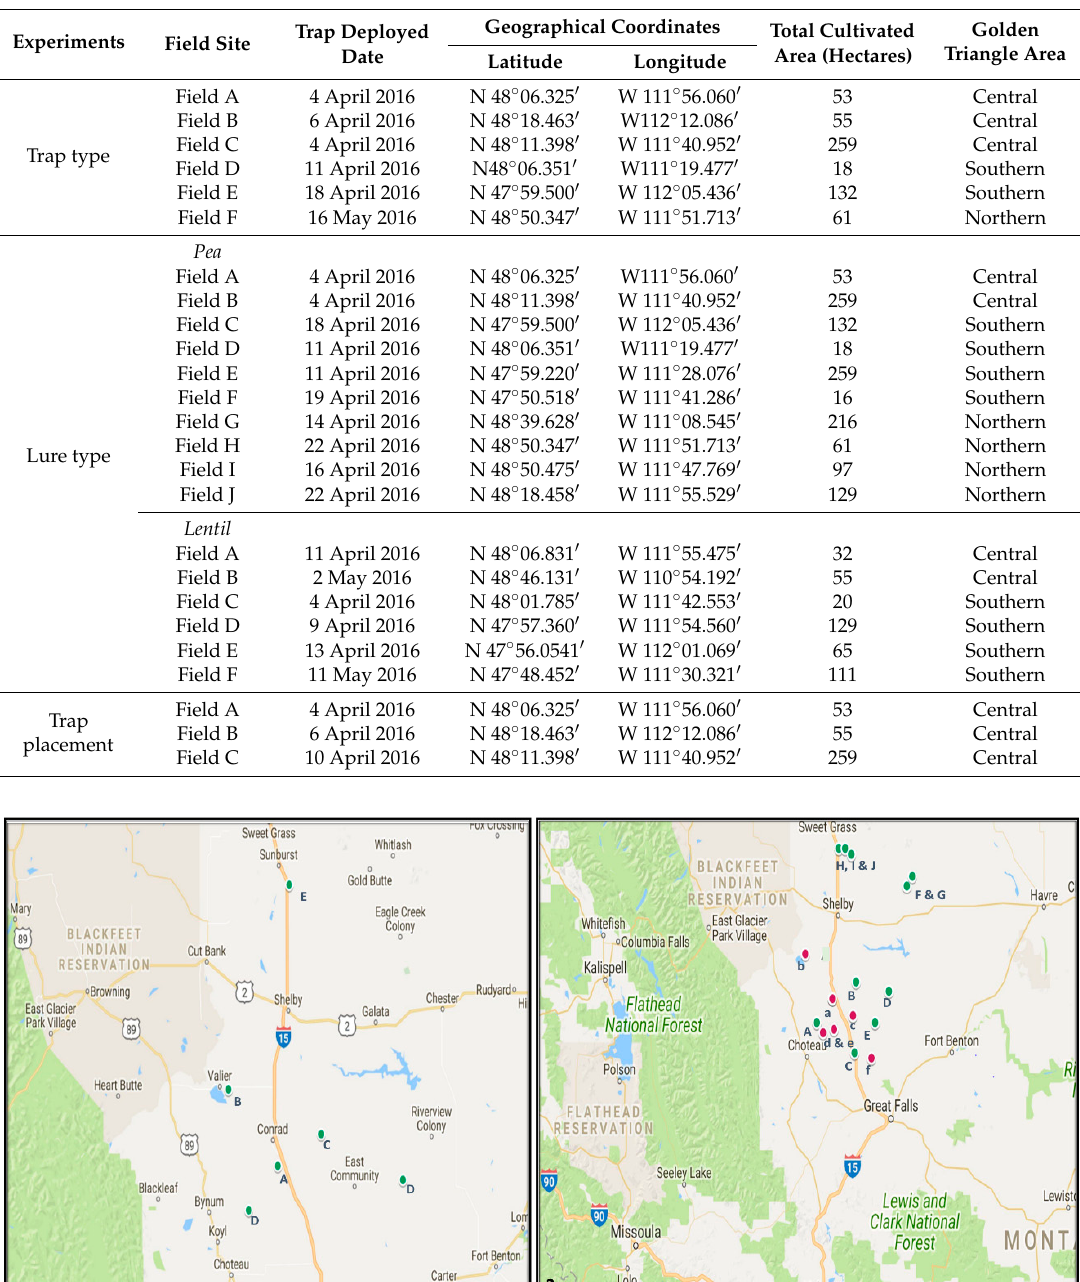
Table 1. Description of field sites for pheromone trapping of Sitona lineatus at the Golden Triangle, Montana, 2016.